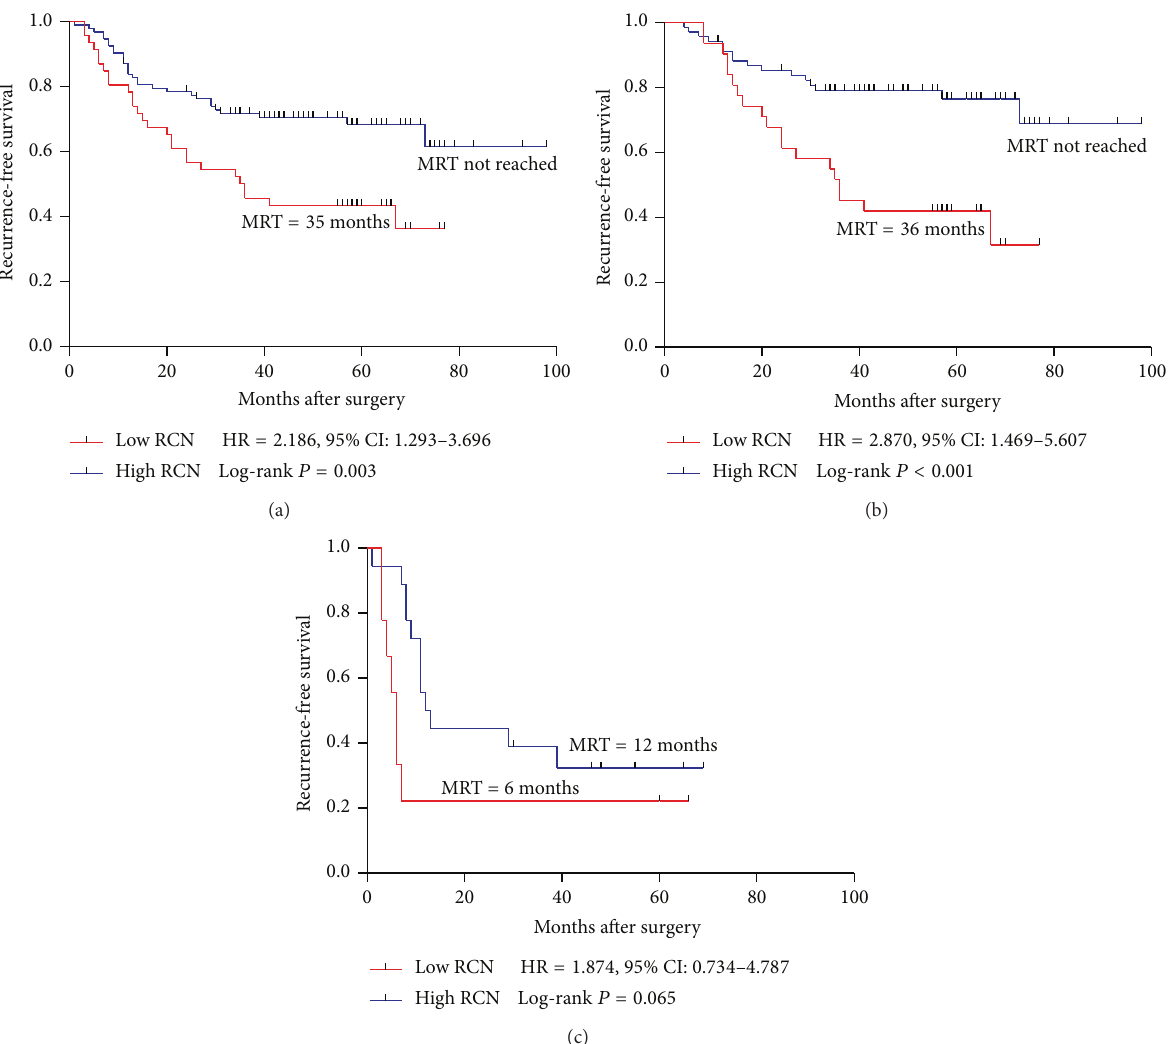
Figure 1: Kaplan-Meier survival curves of patients with stage III, IIIB, and IIIC disease receiving oxaliplatin-based chemotherapy. (a) RFS in total stage III; (b) RFS in stage IIIB; (c) RFS in stage IIIC. MRT: median recurrence